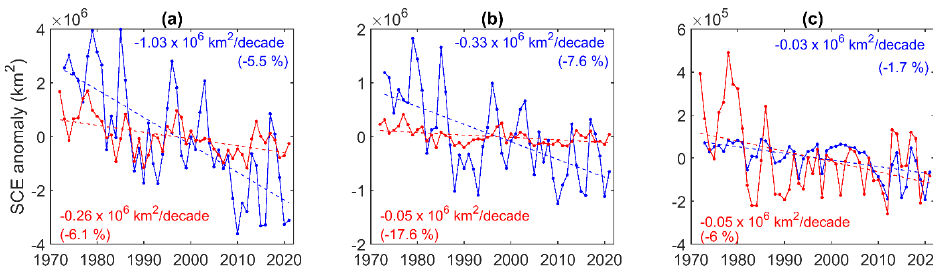
Figure 4. Seasonal trends (red = summer (JAS), blue = spring (AMJ)) in SCE (km/decade) over the 1970–2021 period derived from the NOAA weekly snow cover maps. Relative trends (%/decade) are indicated in parenthesis. ( a ) NH; ( b ) Arctic, ( c ) HA [38]. Despite the difference in the magnitude of the SCE reduction, SCE has declined over- all across all the regions. However, both the Northern Hemisphere (NH) and the Arctic have experienced a significant SCE reduction since 1970 (1.03 and 0.3 million square kilo- metres per decade, respectively) while the HA has encountered a comparatively smaller reduction in spring SCE (0.03 million square kilometre per decade), due to the small area of the region. When looking at relative trends, the SCE reduction in spring has been much slower in the HA ( − 1.7%/decade) than the whole Arctic ( − 7.5%/decade) and NH ( − 5.5%/decade). SCE in the HA has reduced faster in summer ( − 6%/decade) than spring ( − 1.7%/decade), as is the case for the whole Arctic, due to the longer lasting snow cover.